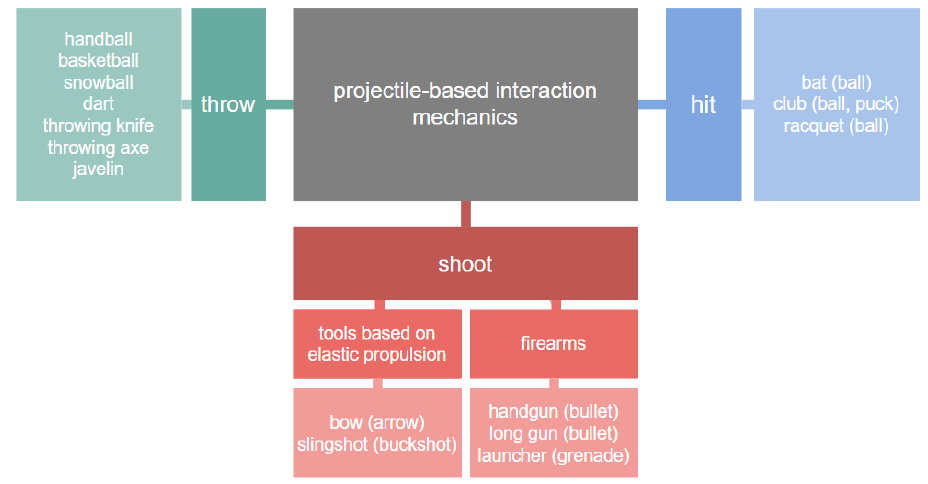
Figure 3. Specific examples of projectile-based interaction